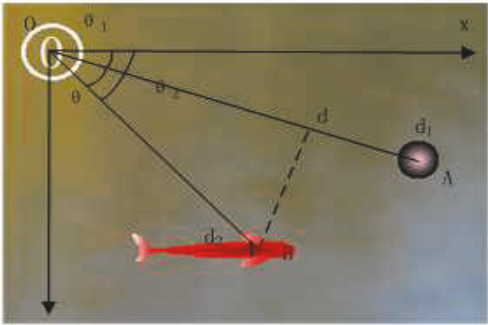
Figure 5: Determine the robotic fish